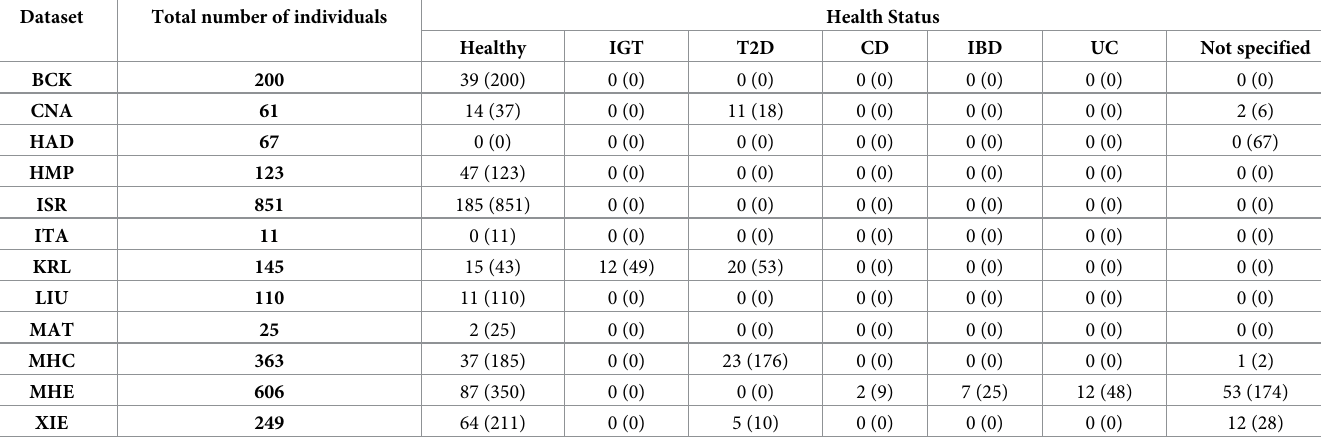
Table 2. Association of health status with prevalence of